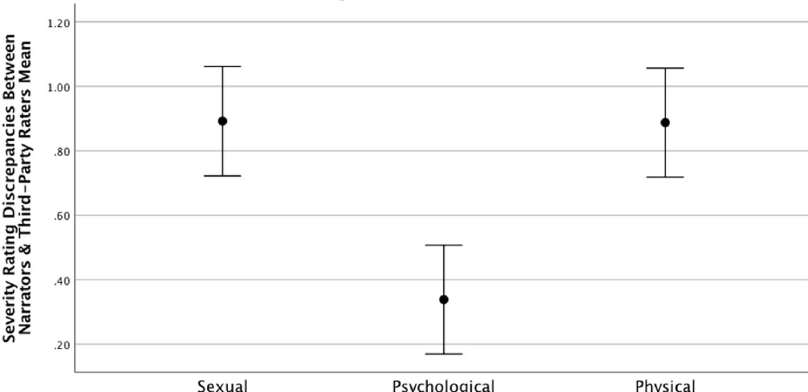
Fig. 4 Severity ratings for the recipients minus the severity ratings for the narrators divided into sexual, psychological, and physical violence. The fi gure shows the severity ratings for the recipients minus the severity ratings for the narrators divided into sexual, psychological and physical violence.